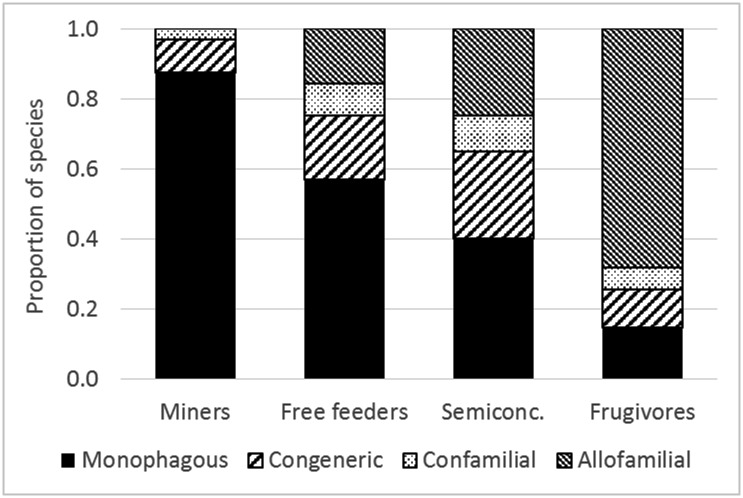
Host specificity of folivorous (mining, freely feeding, and semiconcealed: leaf tying and rolling) and frugivorous guilds of Lepidotera in lowland rainforests of Papua New Guinea.